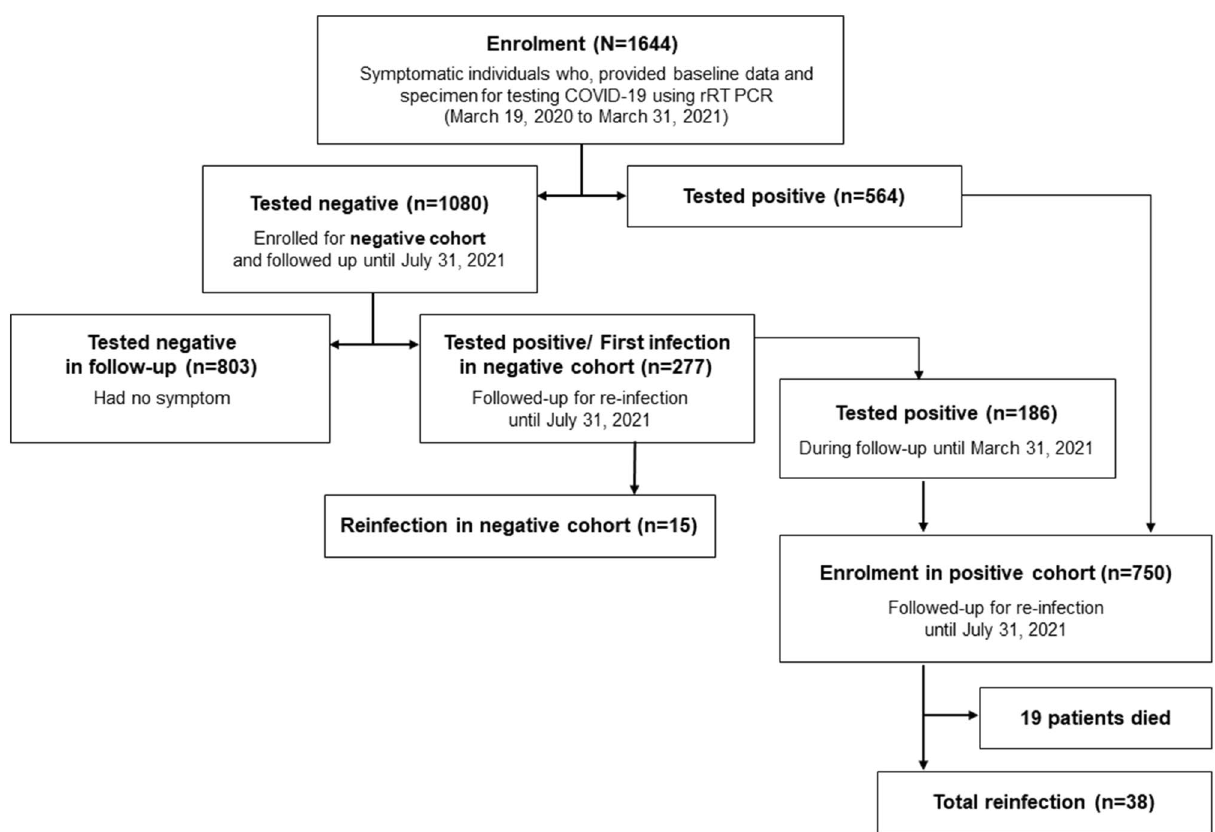
Figure 1. Study profile (participants were enrolled until 31 March 2021, and all participants were followed up until 10 July